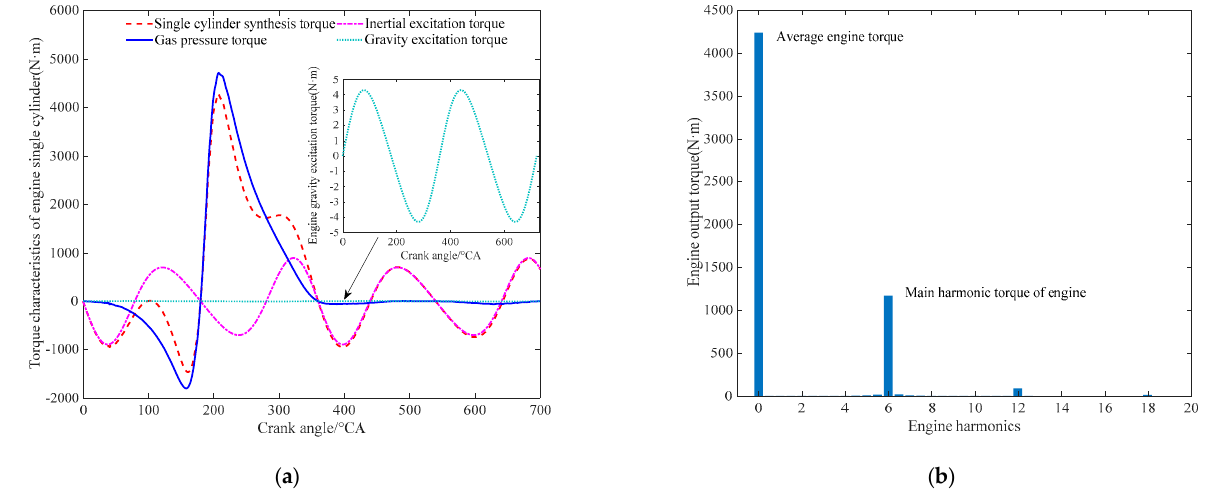
Figure 5. Engine harmonic excitation: ( a ) The excitation torque of engine single cylinder; ( b ) Harmonic relation of engine output torque monic relation of engine output